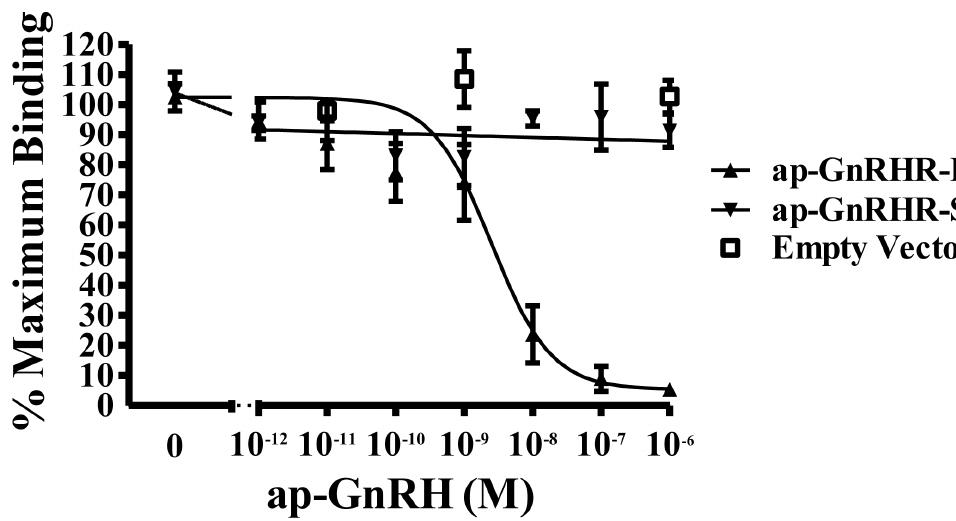
Fig 5. Analysis of [ 125 I]-ap-GnRH binding to S2 cells transfected with ap-GnRHR-L or ap-GnRHR-S. Binding to the radioligand was displaced by increasing concentrations of unlabeled ap-GnRH in S2 cells transfected with ap-GnRHR-L (EC 50 = 2.52 nM), but not ap-GnRHR-S. Binding data are expressed as the percentage of [ 125 I]-ap-GnRH binding to the respective receptor in the absence of unlabeled hormone. Empty vector-transfected cells were used as a negative control. Each data point represents N = 3 assays run in